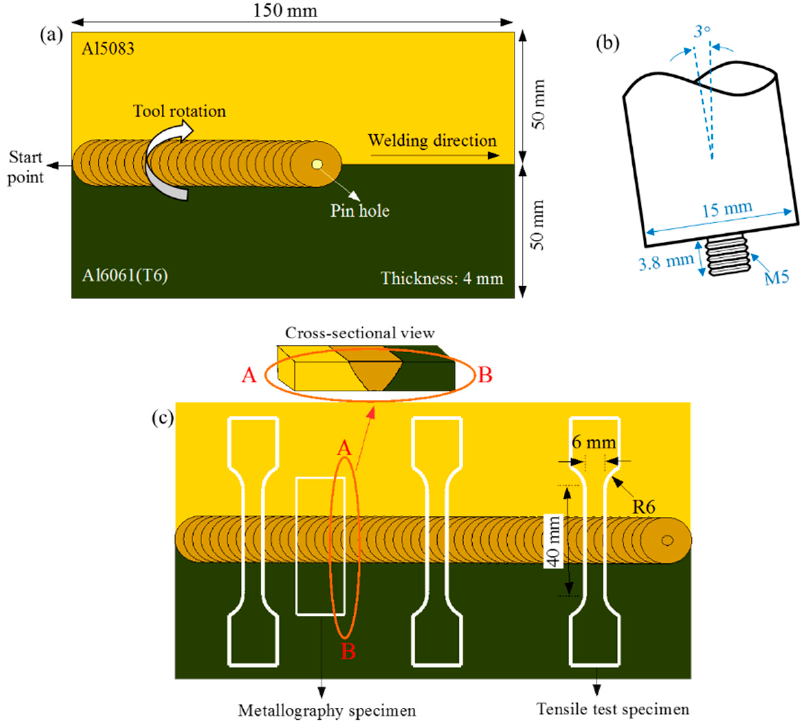
Figure 1. Schematic of the FSW process: ( a ) configuration of the welding joint, ( b ) welding tool, and ( c ) the orientation of samples cutting for microstructure and mechanical testing.